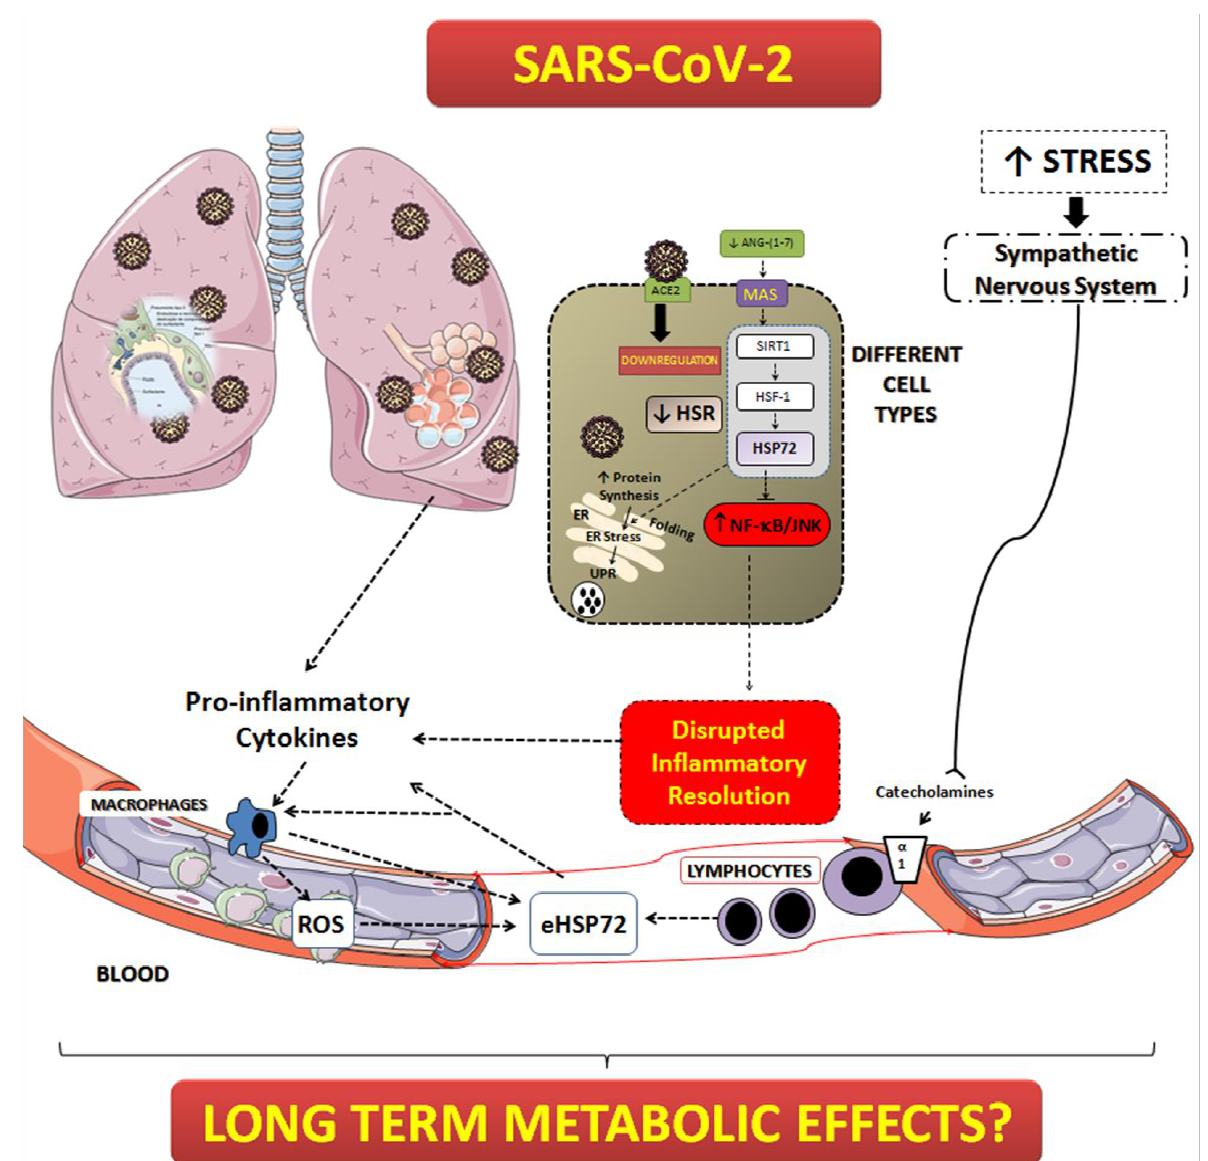
Figure 6 . Possible role of elevated plasma eHSP70 and a lower HSR in a SARS-CoV-2 infection. In several cells, infection caused by SARS-CoV-2 might lead to downregulation of ACE2. This would decrease the production of angiotensin (1-7) and the activation of the MAS receptor. MAS receptor activation induces anti-inflammatory responses and, in addition, by the activation of SIRT1, stim- ulates the HSR pathway [44] . Without this axis, the HSR is diminished and the inhibitory effect of intracellular HSP72 over NF- κ B is absent, leading to a disrupted inflammatory resolution. The cy- tokine storm induces direct damage on cells/tissues and activates, along with the increased sym- pathetic tonus, the release of HSP72 to the extracellular environment (eHSP72) [45] . Extracellular HSP72 might reinforce the inflammatory system and induce activation of TLR (Toll-like receptors, particularly TLR4) in several cell types, including pancreatic beta cells and skeletal muscle [11]. The chronic activation of the TLRs by eHSP72 might reduce the capacity of the HSR activation, wors- ening the inflammatory response and altering metabolic status. In different cell types, the higher demand for protein synthesis may lead to the un- folded protein response (UPR) and endoplasmic reticulum stress (ER stress) [13]. The